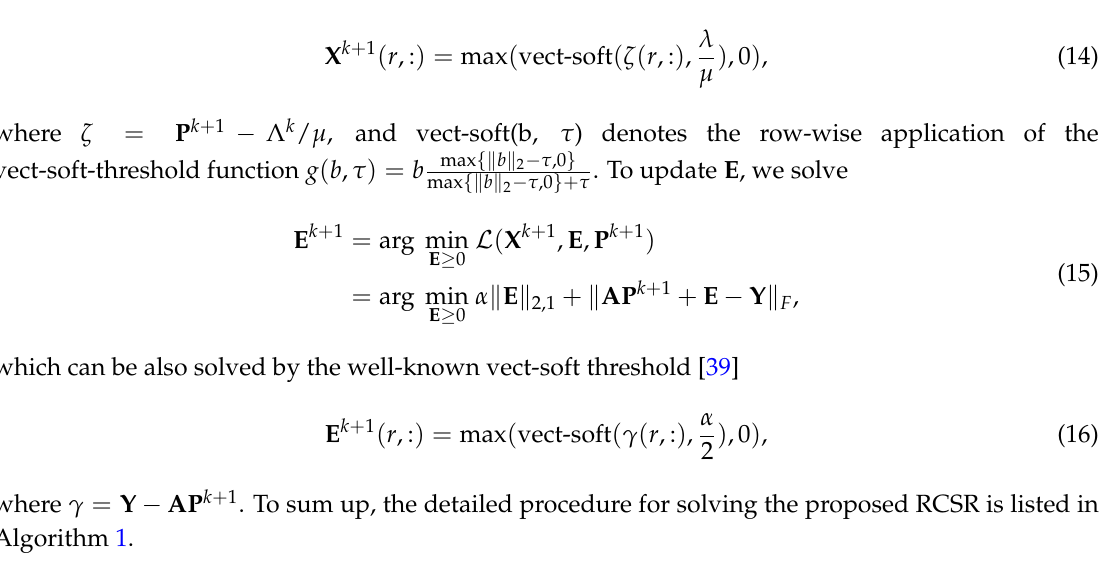
Algorithm 1: Solving (9) with